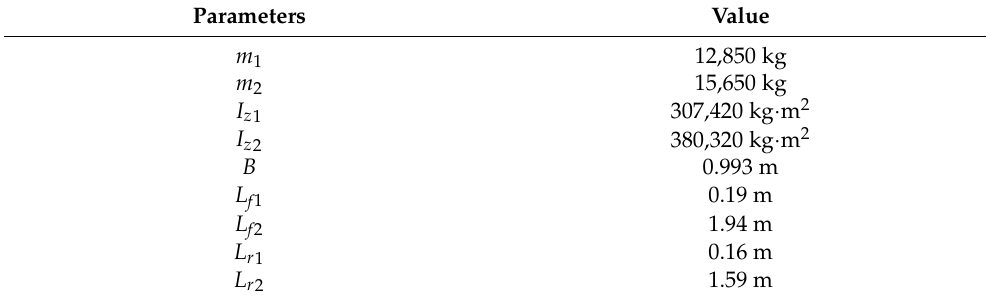
Table 1. Main involved parameters.